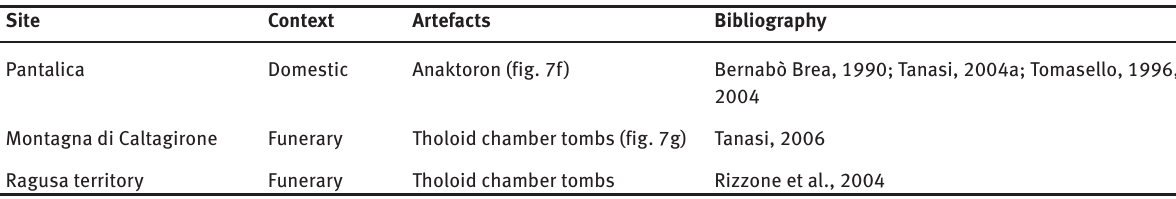
Table 10: Architectural Elements of Mycenaean Origin in Late Bronze Age